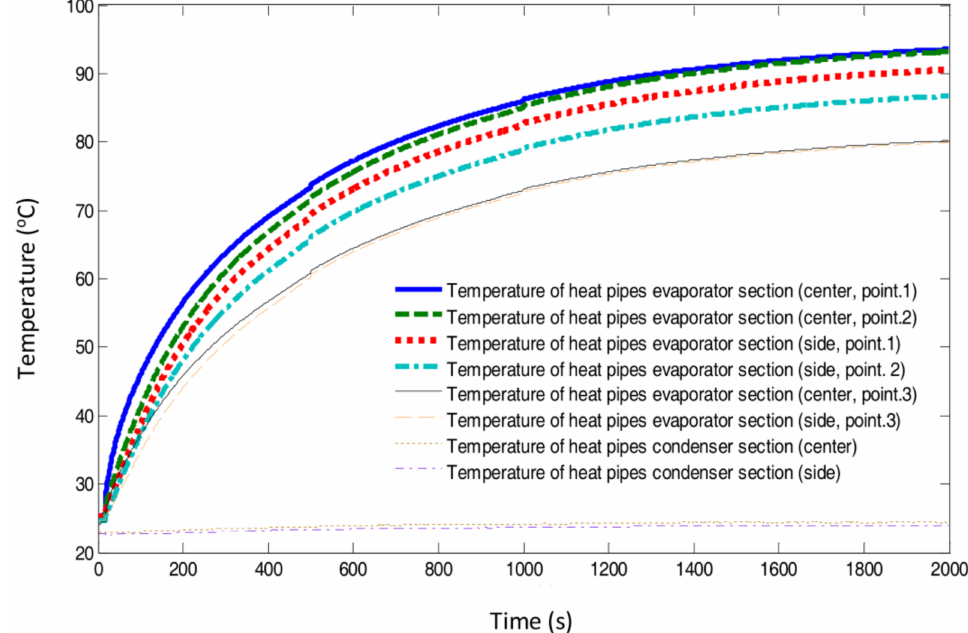
Figure 6. Temperature as a function of time in the evaporator and the condenser section of the heat pipes (diameter of 6 mm, effective length of 190 mm pressed thickness of 2 mm and width of 8.50 mm at the evaporator section) in different locations (against gravity orientation). The error of 1% was associated with the results using the heat supply rate of 55